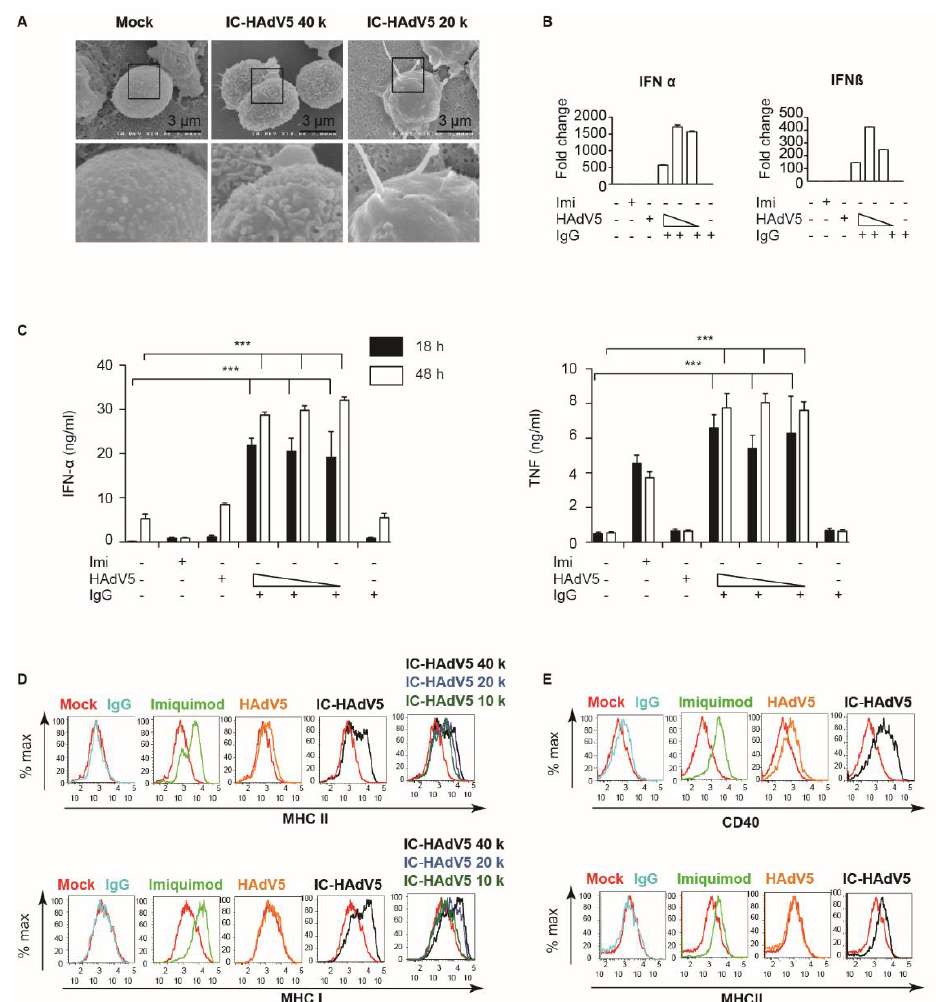
Figure 2. pDC activation. ( A ) Electron micrograph of pDCs mock-treated or challenged with IC-HAdV5 2—4 × 10 5 pp/cell. Sixty cells were imaged in three independent experiment and representative images, as illustrated. ( B ) The mRNA levels of IFN α and IFN β from pDCs exposed to the milieu from IgG, HAdV5-, and IC-HAdV-challenged at 4 h post-activation by qPCR. The cytokine sequences were designed in-house. ( C ) The IFN- α and TNF levels in the supernatant of pDCs challenged with IgG, HAdV5-, and IC-HAdV. Challenged at 18 h and 48 h post-activation. n ≥ 3 donors. p values were derived from a one-way ANOVA with Dunnett’s post-test. *** corresponds to p < 0.0001 and denotes significant difference. Imiquimod was used as a positive control. ( D , E ) The cell surface levels of MHC I and II ( D ) and CD40 ( E ). Quantified 18 h post-stimulation with Imiquimod, HAdV5, or increasing doses of IC-HAdV5. n = 3 donors with similar results. To address this mechanism using another approach, we used AdL40Q, a HAdV5 capsid containing a mutation (L40Q) in protein VI that attenuates its membrane lytic ac- tivity [10,27,28]. Consistent with the above data, IC-AdL40Q also had a lower capacity to induce TNF, an IFN-α secretion, compared to IC-HAdV5 (Figure 3E). Together, these data demonstrate that IC-HAdV5 are taken up by pDCs in endocytic vesicles that acidify, re- leasing an internal HAdV5 capsid protein that then allows partially degraded capsids to be detected by TLR9, and induce pDC activation.